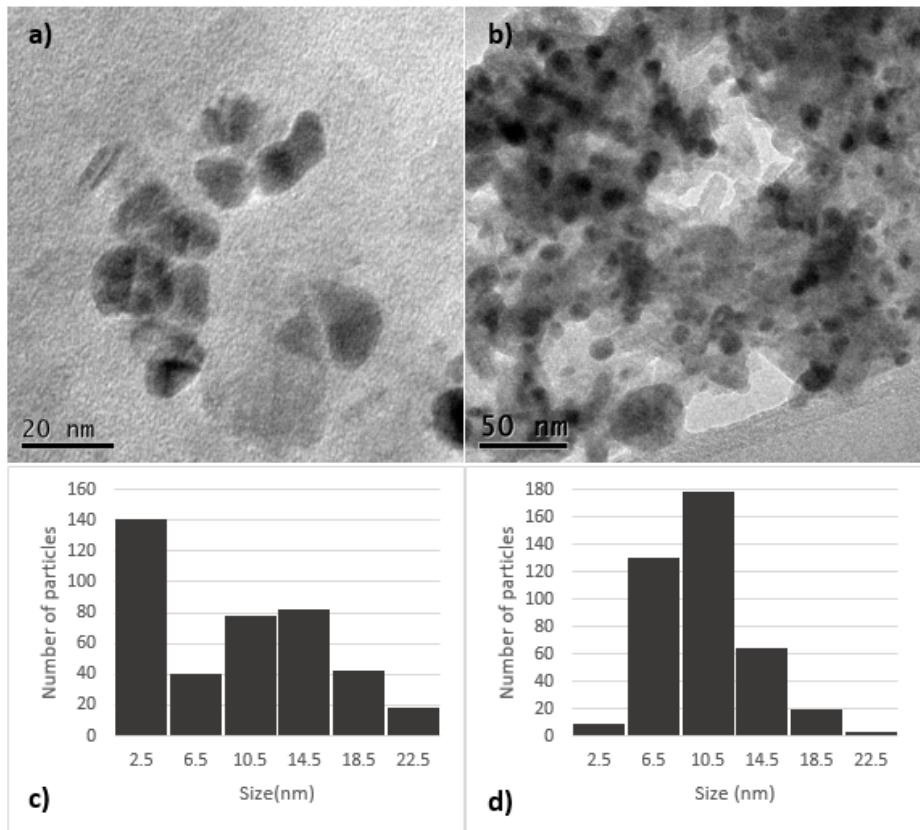
Figure 1. ( a ) TEM image of 1% Ag/bovine bone powder, ( b ) TEM image of 5% Ag/bovine bone powder, ( c ) size distribution of silver nanoparticles (1%) on bovine powder, and ( d ) size distribution of silver nanoparticles (5%) on bovine powder.